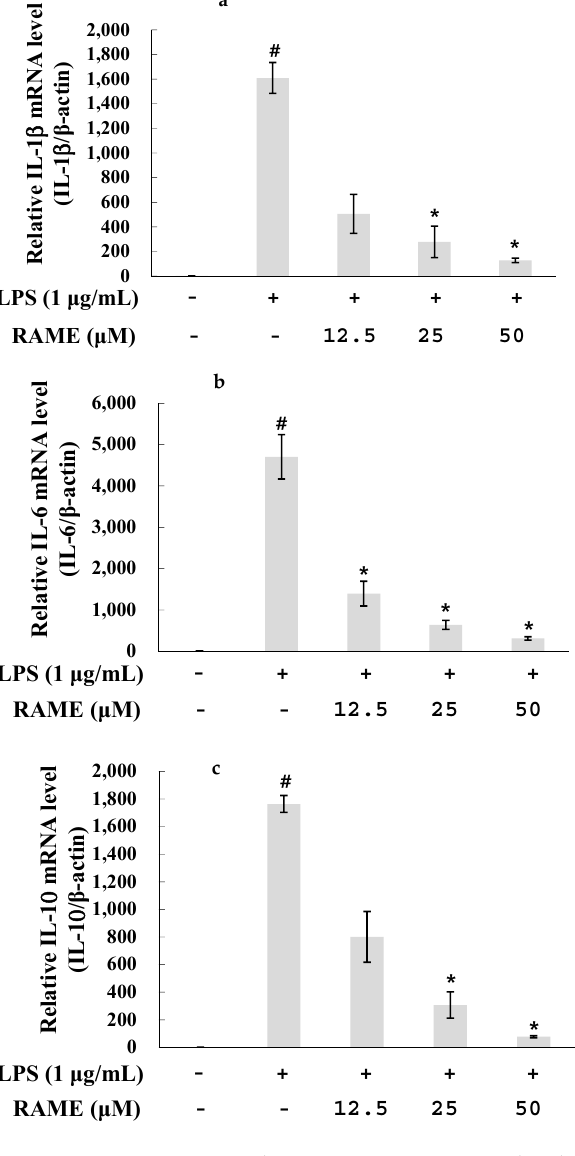
Figure 4. Effects of RAME on IL-1 β , IL-10, and IL-6 mRNA expression levels in LPS-treated RAW 264.7 cells. The expression level of pro-inflammatory cytokine genes were measured by real-time PCR. RAW 264.7 cells were treated RAME (12.5, 25, and 50 µ M) with LPS (1 µ g/mL) and incubated for an additional 18 h. mRNA expression level of genes was normalized with β -actin. ( a ) IL-1 β mRNA expression level; ( b ) IL-6 mRNA expression level; ( c ) IL-10 RNA expression level. The results are presented as the means ± SDs of three replicates of one representative experiment. # p < 0.05 vs. control group , * p < 0.05 vs. LPS-treated group.